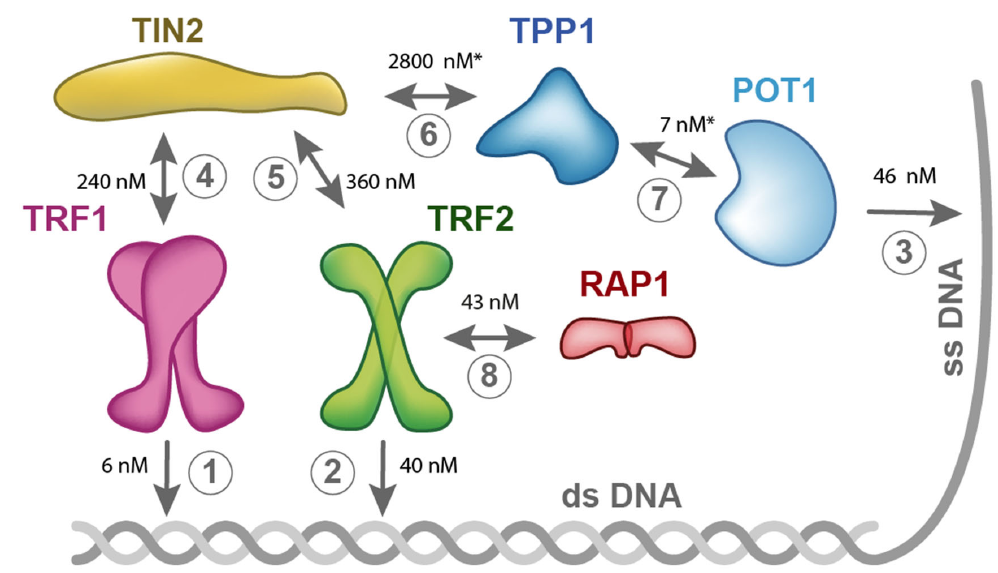
Figure 3. Binary interactions within shelterin measured in our laboratory. Binding studies with six shelterin proteins were carried out using fluorescence anisotropy (1, 2, 3, 7, 8) and thermophoresis (4, 5, 6). The asterisks denote that the Kd values were determined for truncated variant of TPP1 (89–544aa) and POT1 (312–634aa). All other quantifications of interactions were carried out with full-length proteins. The binding buffer was 50 mM sodium phosphate, pH 7.0, 50 mM NaCl. The binding temperature was 25 ◦ C, except for 1 where 10 ◦ C was used to secure TRF1 protein stability during measurements. Kd values were determined as the mean of at least three independent experiments with a relative standard deviation of less than 10%.